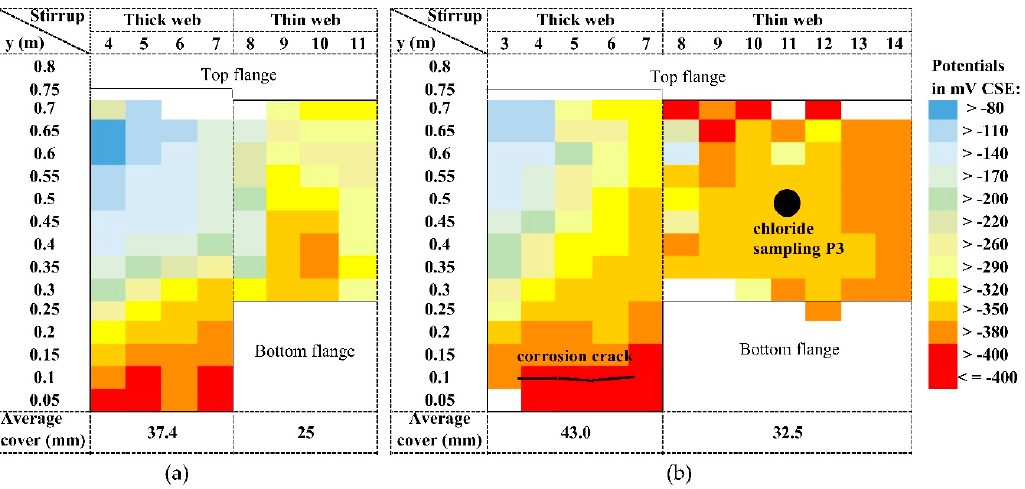
Figure 9. HCP measured above the stirrups in Girder 2: ( a ) inner surface; ( b ) outer surface (facing the sea) cf. Figure 2 and Figure 6.